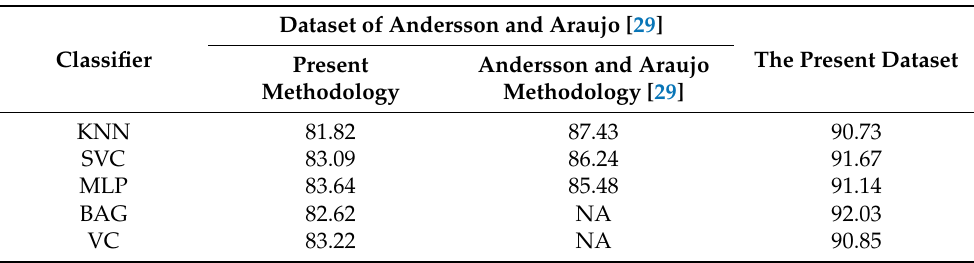
Table 3. Accuracy of gender classification based on the Kinect gait biometry dataset of Andersson and Araujo [29] and the present dataset implementing 140